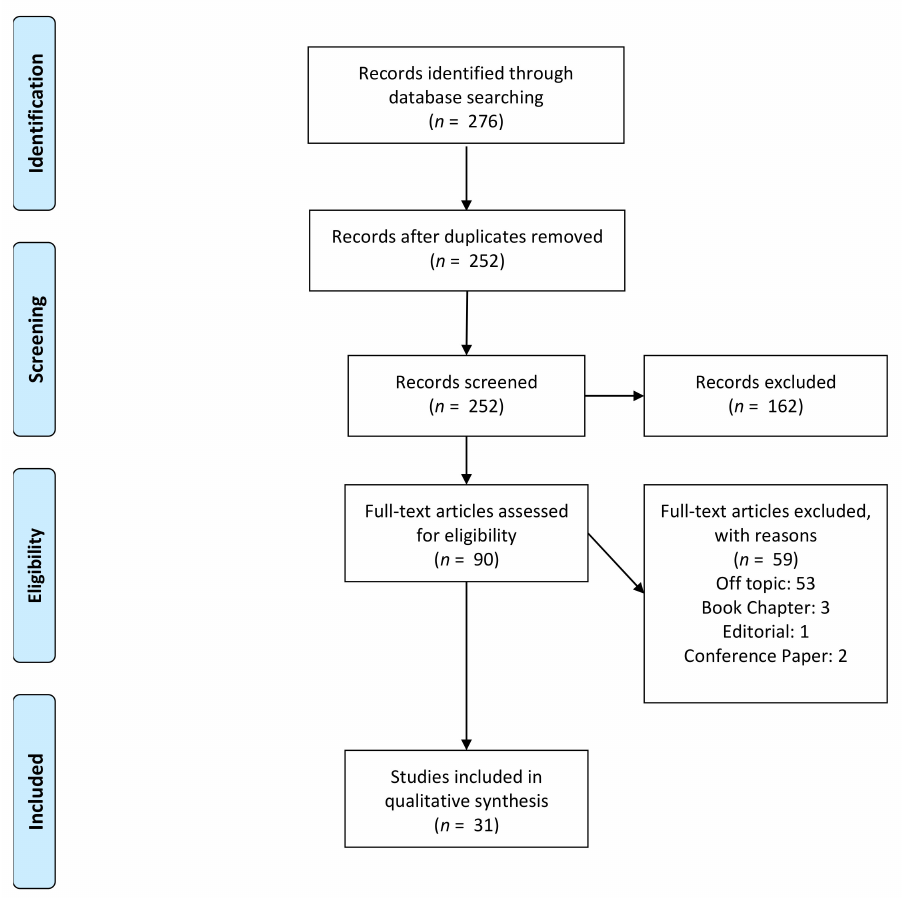
Figure 4. PRISMA flowchart of the article screening and inclusion for the qualitative synthesis